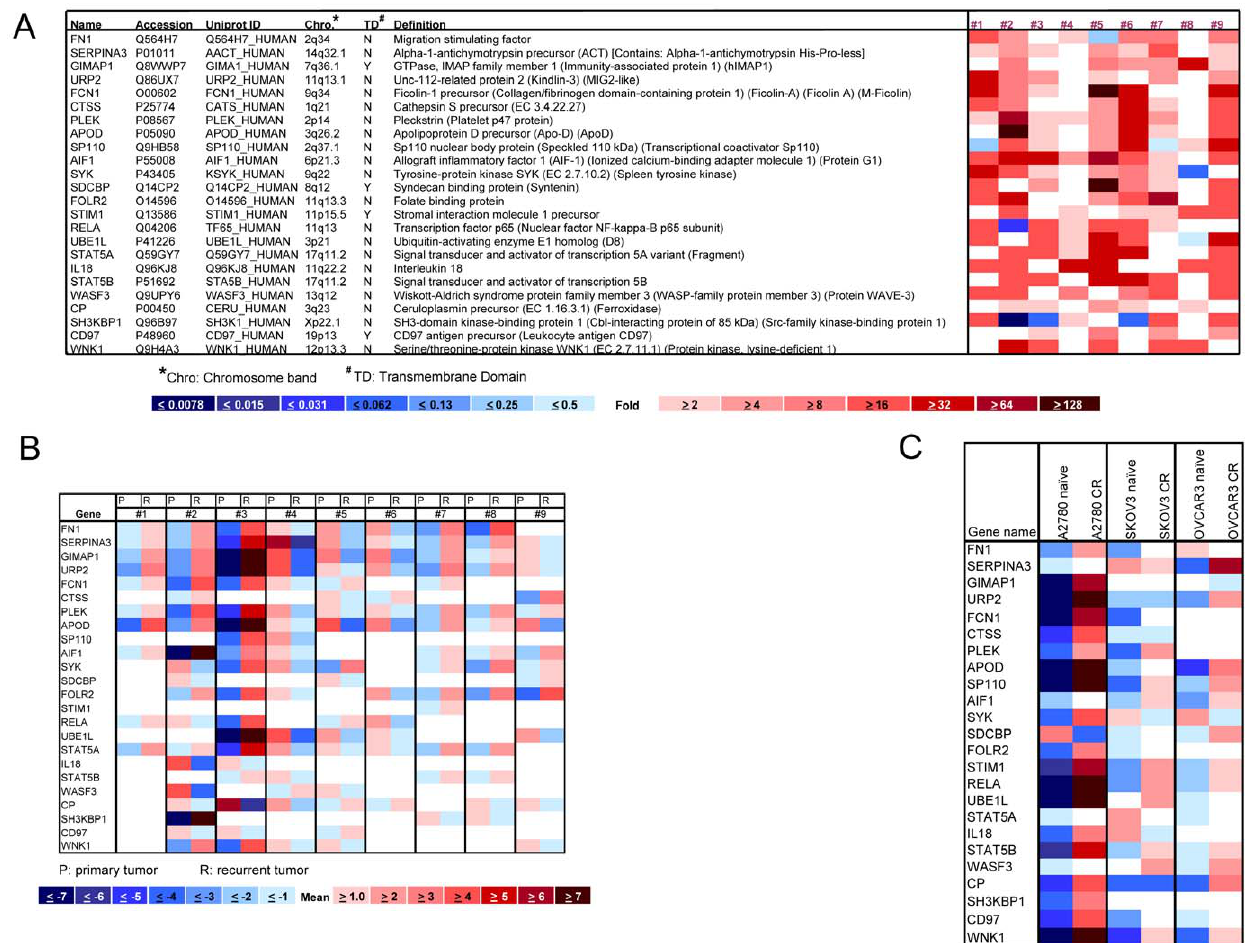
Figure 1. Identification and validation of candidate proteins in recurrent ovarian serous carcinoma. A) Proteomics analysis showing the expression ratio of recurrent to primary tumor in 24 candidate proteins. Nine pairs of matched primary and recurrent serous carcinomas (from # 1 to # 9) were analyzed and the pseudo-color codes represent the fold change (ratio of recurrent to primary tumor) from low (blue) to high (red). B) mRNA expression of candidate genes in recurrent and primary tumors using the same 9 pairs of samples utilized in proteomics analysis. Color codes represent the relative expression levels from low (blue) to high (red). C) mRNA expression of candidate genes in chemoresistant ovarian cancer cells; CR = Carboplatin Resistant. Color codes represent the relative expression levels from low (blue) to high